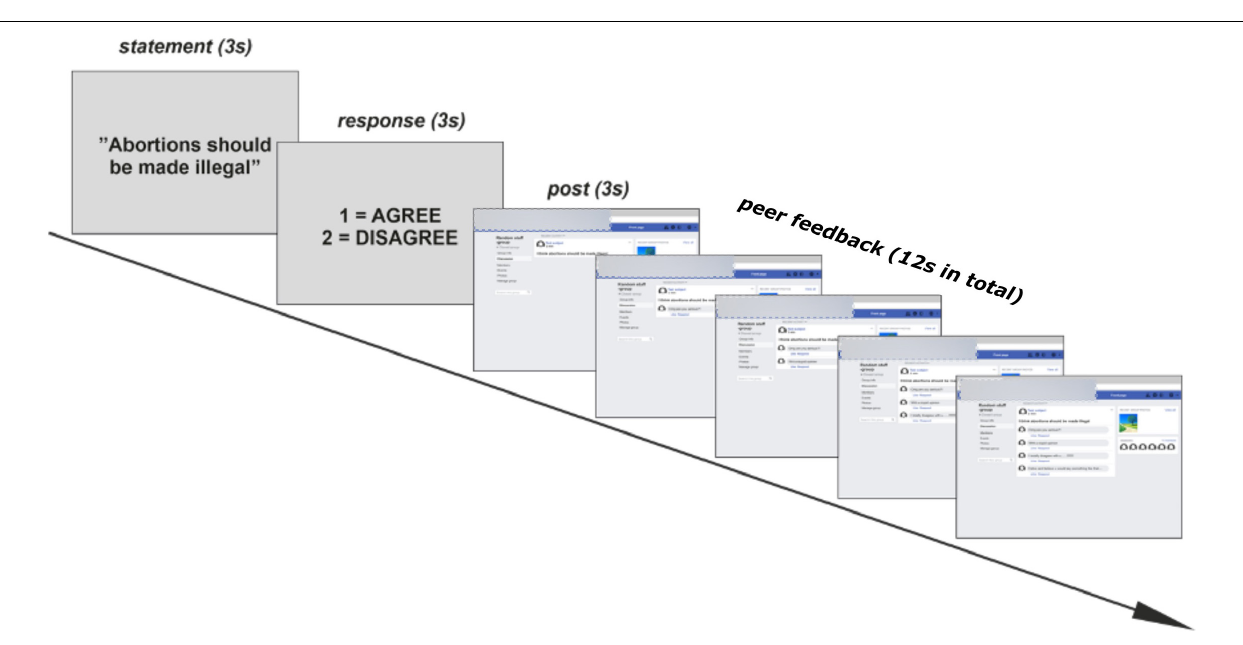
Frontiers in Behavioral Neuroscience |